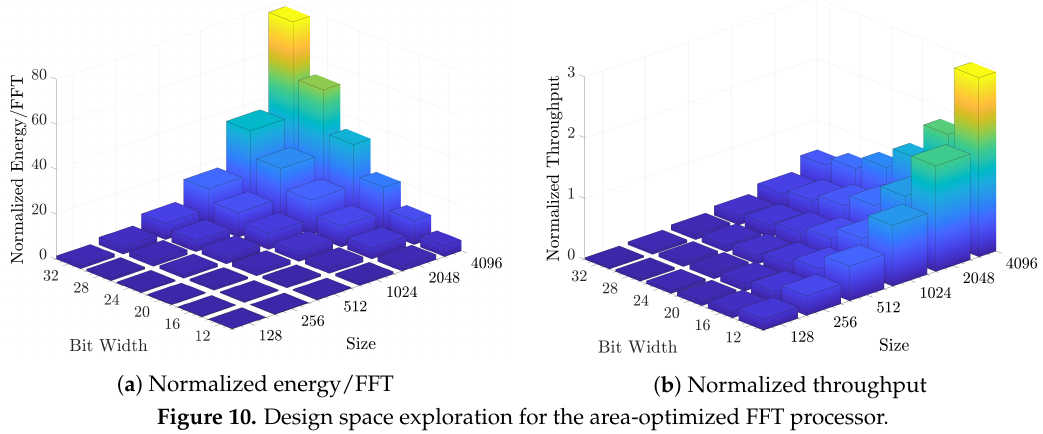
Figure 10. Design space exploration for the area-optimized FFT processor.